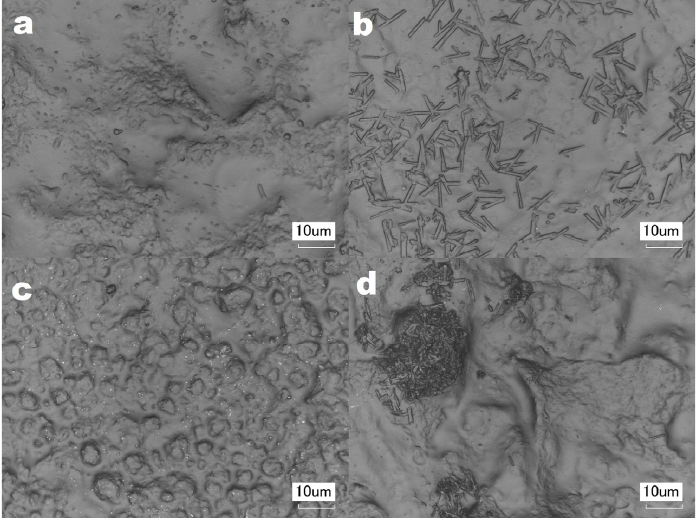
Figure 9. Microphotographs (magnification of 3000×) of starch films plasticized with deep eutectic solvent: with the addition of 1% ( a ) sodium (S_CM_MMTNa_1) or ( b ) calcium (S_CM_MMTCa_1) montmorillonite, ( c ) without filler (S_CM_0), ( d ) with addition of 7% of calcium montmorillonite (S_CM_MMTCa_7).